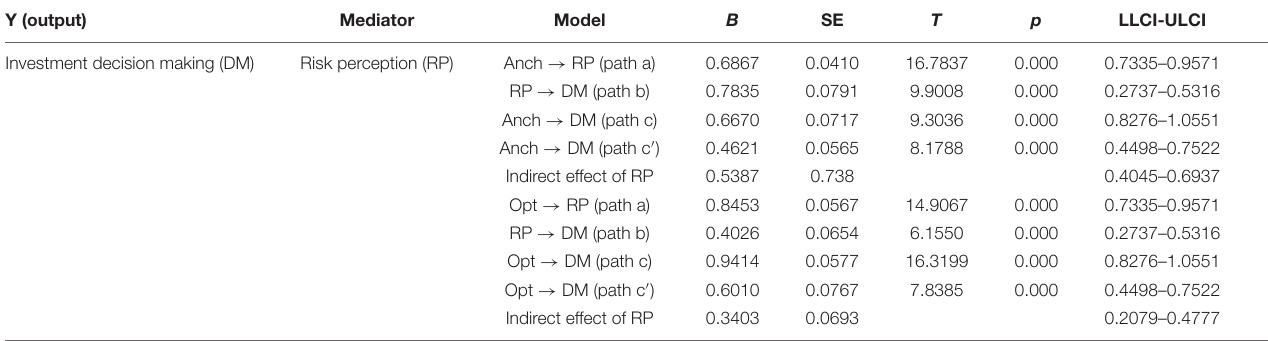
TABLE 4 | Effect of cognitive biases (Anchoring bias and Optimism bias) on investment decision making (DM) via mediating role of Risk perception. Y